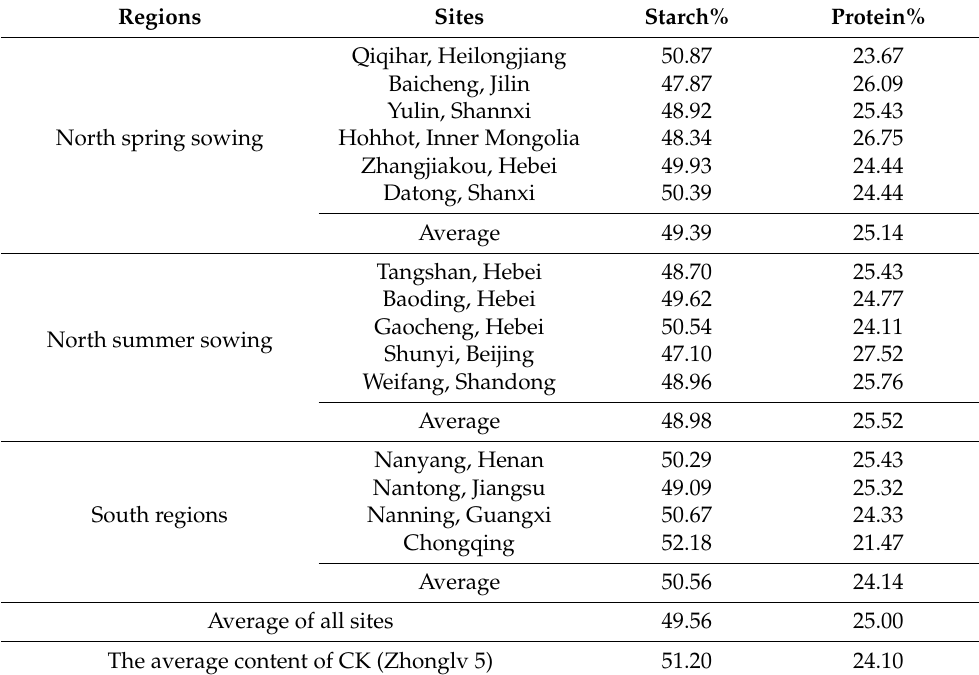
Table 4. Results of a seed quality analysis of Jilv 20 grown at different multi-ecological identification test